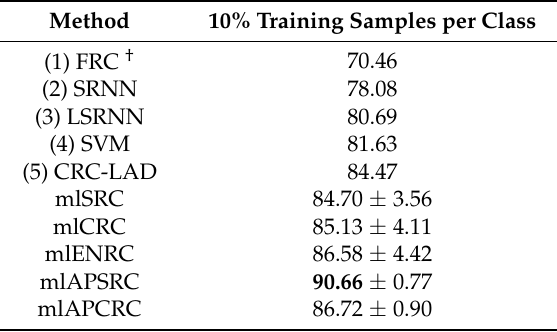
Table 9. Comparison of the methods, denoted as mlSRC, mlCRC, mlENRC, mlAPSRC and mlAPCRC, with the results reported in (1) [34], (2) to (3) [33] and (4) to (5) [28], for the Indian Pines image. The best OA results are marked in bold. FRC, fused representation-based classification; SRNN, sparse representation-based nearest neighbor classifier; LSRNN, local sparse representation-based nearest neighbor classifier; SVM, support vector machine; CRC-LAD, collaborative representation classification with a locally-adaptive dictionary.